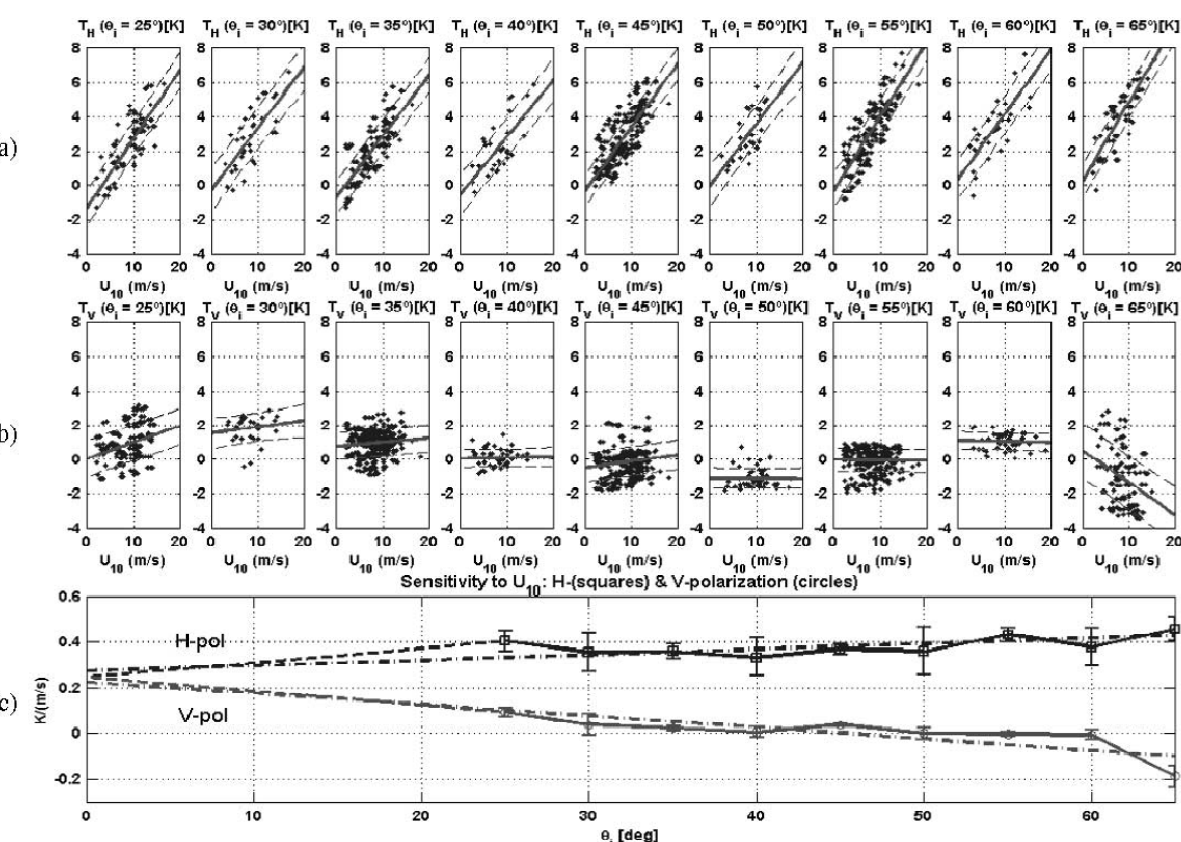
Figure 1. Derivation of the brightness temperature sensitivity to wind speed. Scatter plots of the brightness temperature change at (a) horizontal ( Δ T ) and (b) vertical ( Δ T ) B h B v polarizations vs. the 10-m height wind speed (U ). Solid line: linear fit, and dashed lines: 10 percentile 50% as a function of U for incidence angles from 25 ° to 65 ° . (c) Derived T 10 B h,v sensitivity to wind speed as a function of (solid line) polarization and incidence angle, associated ± 1 σ error bars, and (dashed lines) linear fit. All data points used (Figure 6 from